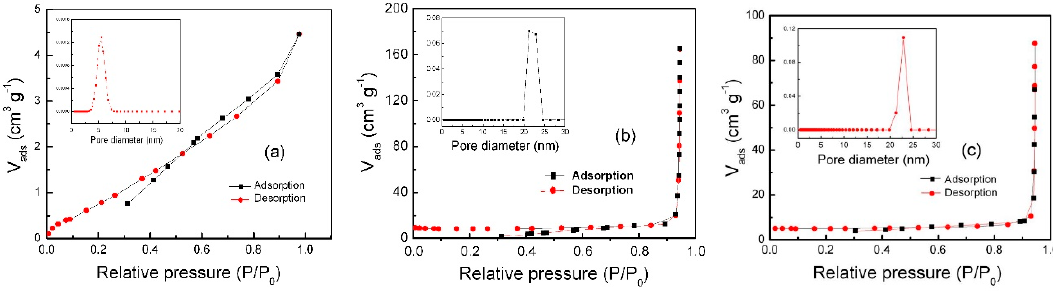
Figure 7. Nitrogen adsorption / desorption isotherms for: ( a ) pristine LMO; ( b ) Ag / LMO(a); and ( c ) Ag / LMO(v). The insets show the pore size distribution.